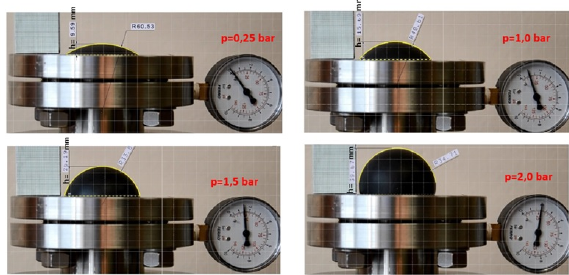
Figure 10: Fitting curves of the M-R model to experimental data: 1 – approximation of the uniaxial tensile ; 2 – approximation of the biaxial tensile; 3 approximation of the uniaxial shear –; 4 – experimental data set of the uniaxial tensile; 5 – experimental data set of the biaxial tensile